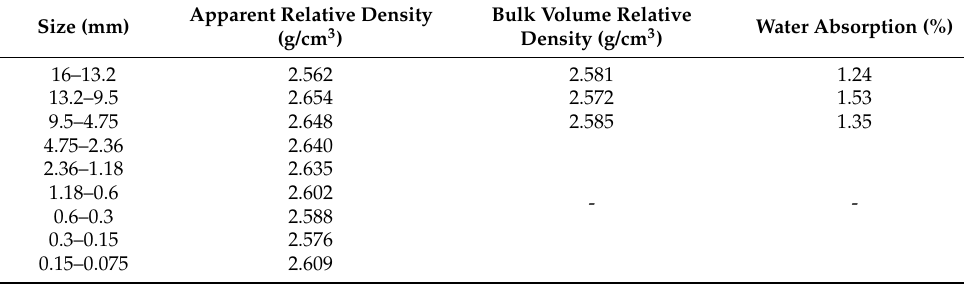
Table 3. Aggregate density test results.